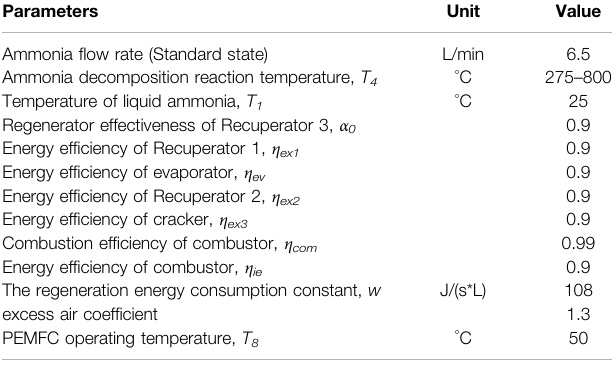
TABLE 4 | System parameters. Parameters Unit Value Ammonia fl ow rate (Standard